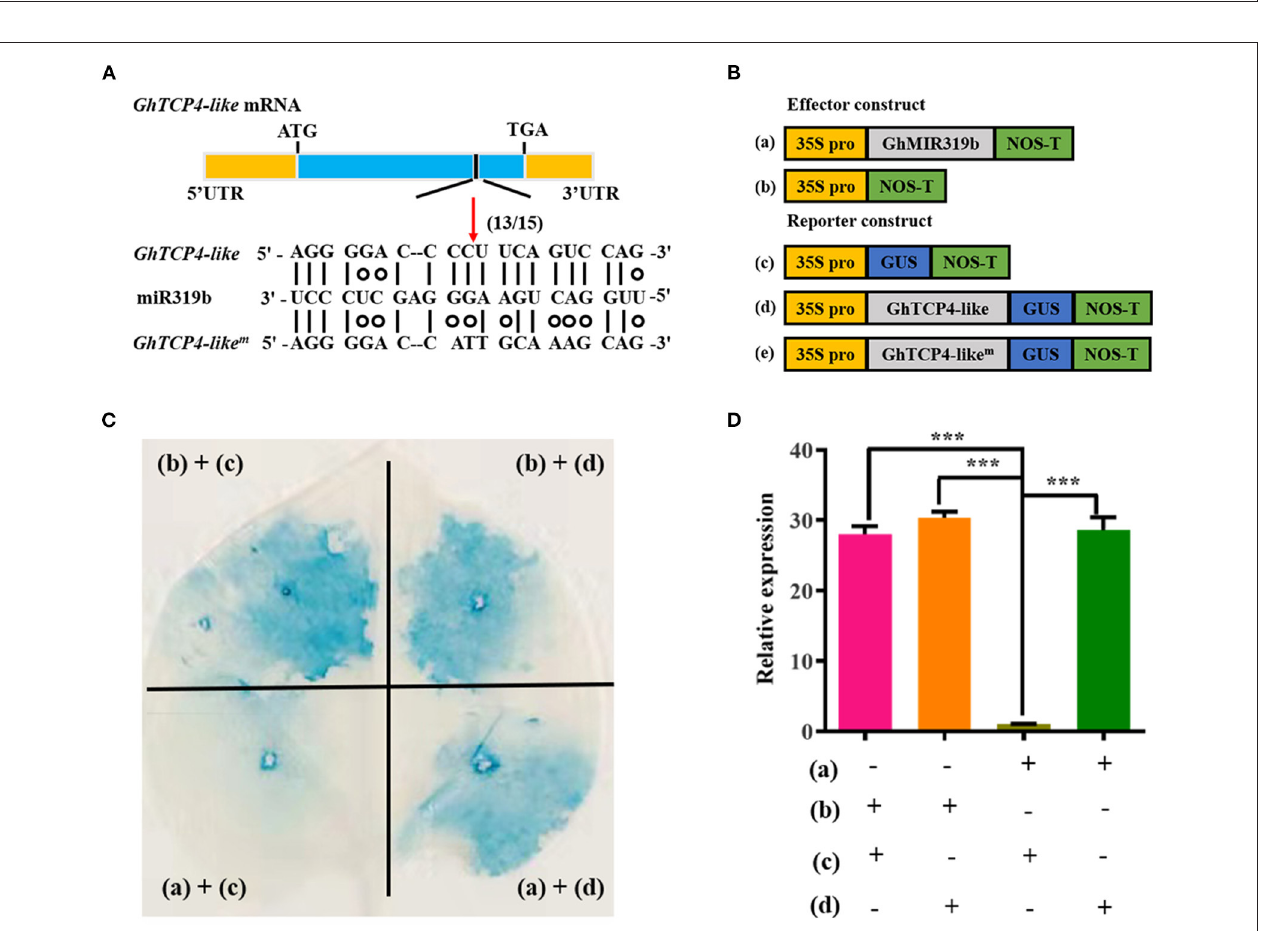
FIGURE 2 | GhTCP4-like directedly cleaved by ghr319b. (A) Diagram of the structure of GhTCP4-like transcript and 5 ′ -RACE analysis. GhTCP4-like m is an equivocal mutation sequence of GhTCP4-like mRNA on the ghr-miR319b target sequence. The black box points to the predicted cleavage site at 980-nt of GhTCP4-like mRNA. (13/15) represents that 13 out of 15 clones are cleaved in target sequence by sequencing. (B) Schematic diagram of the constructs for transient expression assay. (a), (b), (c) and (d) represent 35S:GhMIR319b, pCAMBIA1300, 35S:GhTCP4-GUS and 35S:GhTCP4-like m -GUS, respectively. (C) GUS staining assay. The combinations of A. tumefaciens containing vectors labeled in the edge indicated in (B) were co-injected into the tobacco leaf cells. (D) GhTCP4-like relative expression in treated leaf spots as indicated in (C) . Error bar means SD of three independent biological replications. Student’s t -test was performed, *** p < 0.001. Leaves were harvested 48h after agroinfiltration. All experiments were replicated at least three